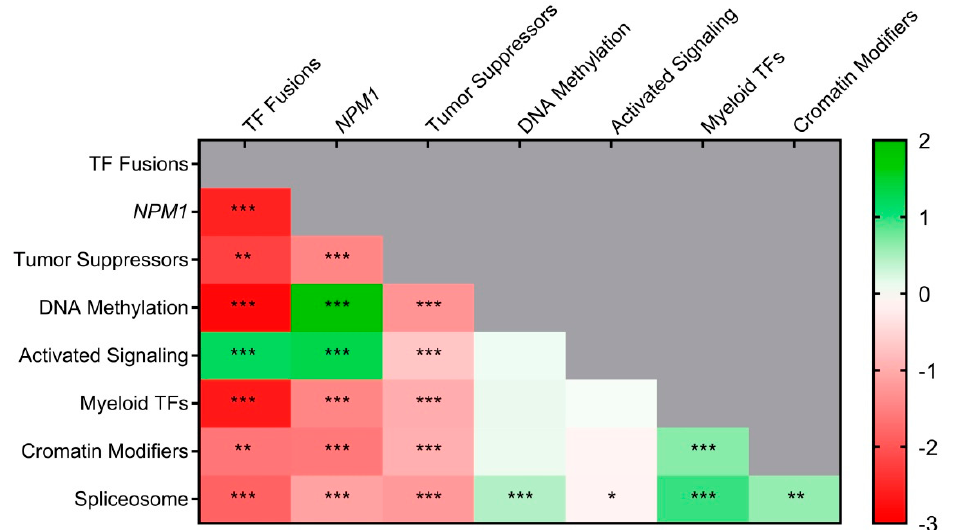
Figure 2. Heatmap of association and exclusivity patterns among functional categories. Red: exclusivity relationship; Green: co–occurring relationship. Higher color intensity indicates stronger association. * p < 0.05, ** p < 0.01, *** p < 0.001.